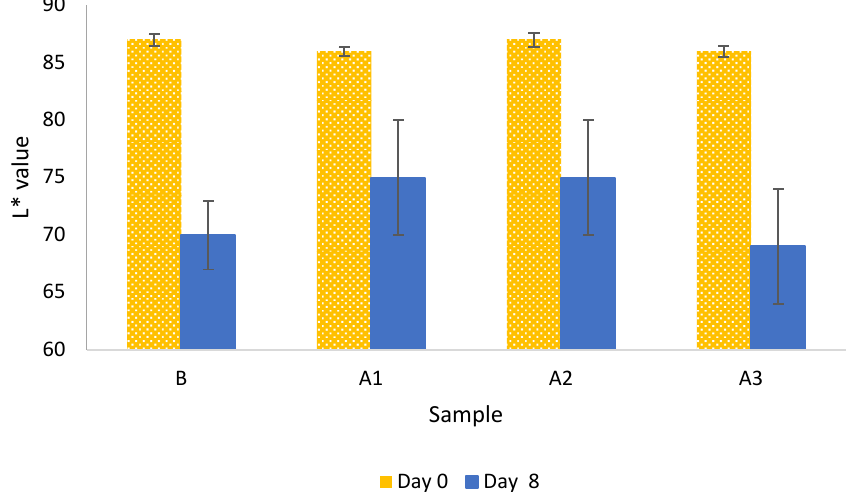
Figure 2. Average values (n = 10) of L* of the samples studied the initial day (yellow dotted bars) and after 8 days (blue bars). Error bars represent the standard deviation.